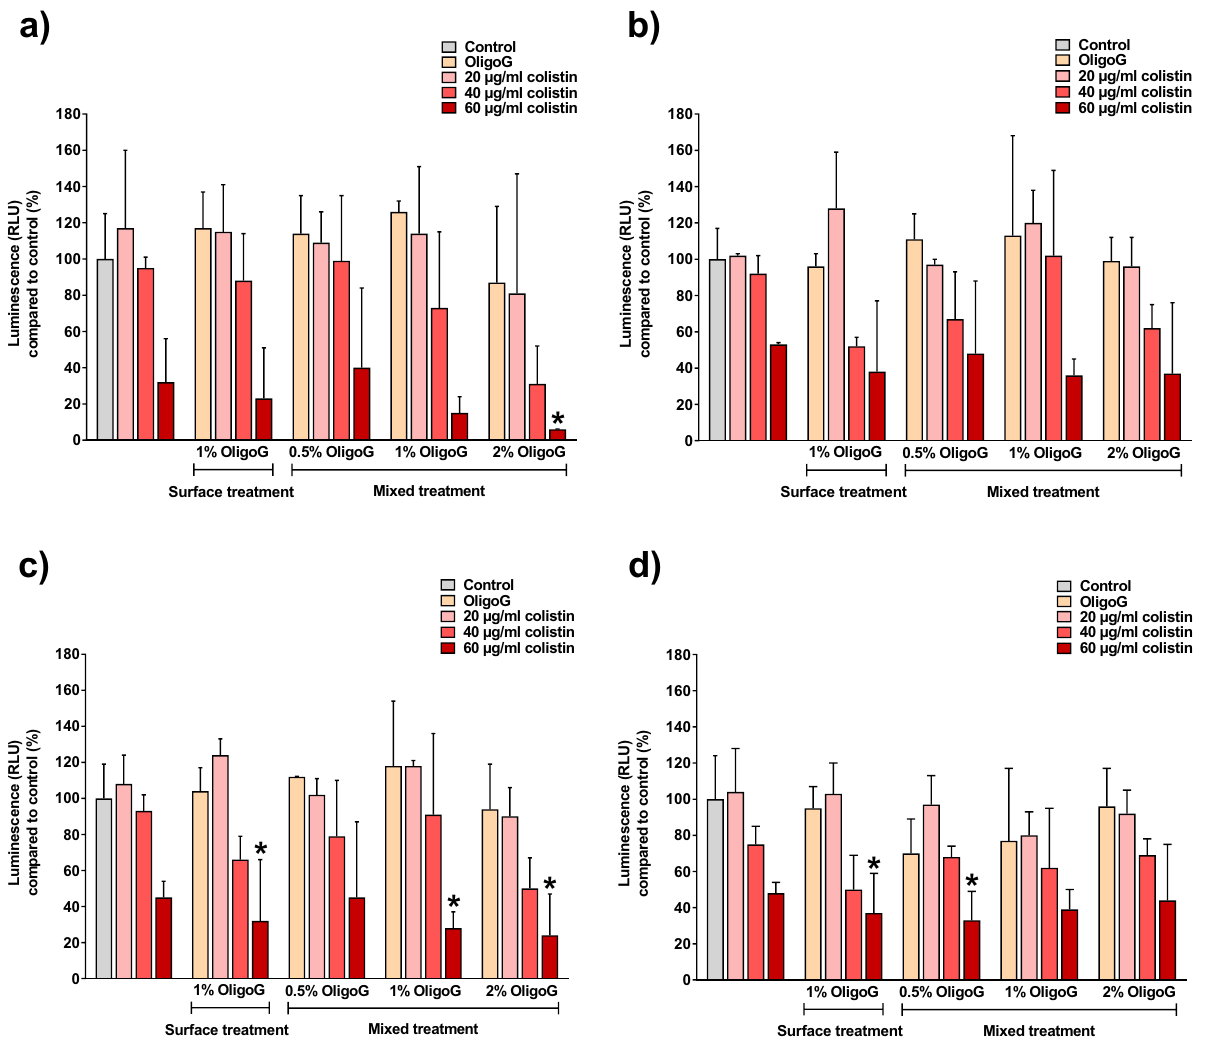
Figure 3. Cell viability (showing ATP production using the CellTiter-Glo assay) of 24 h P. aeruginosa NH57388A biofilms, following 24 h treatment with colistin ± OligoG (0.5, 1 and 2% w/v) added either directly to the artificial sputum (AS) medium surface or pre-incubated with AS medium for 4 h (± SD; n = 2). ( a ) Planktonic bacteria from the biofilm supernatant. ( b ) Planktonic bacteria after biofilm washing. ( c ) Total planktonic bacteria (a + b). ( d ) Attached biofilm bacterial population. Significant difference is indicated by *, where * p < 0.05 compared to untreated